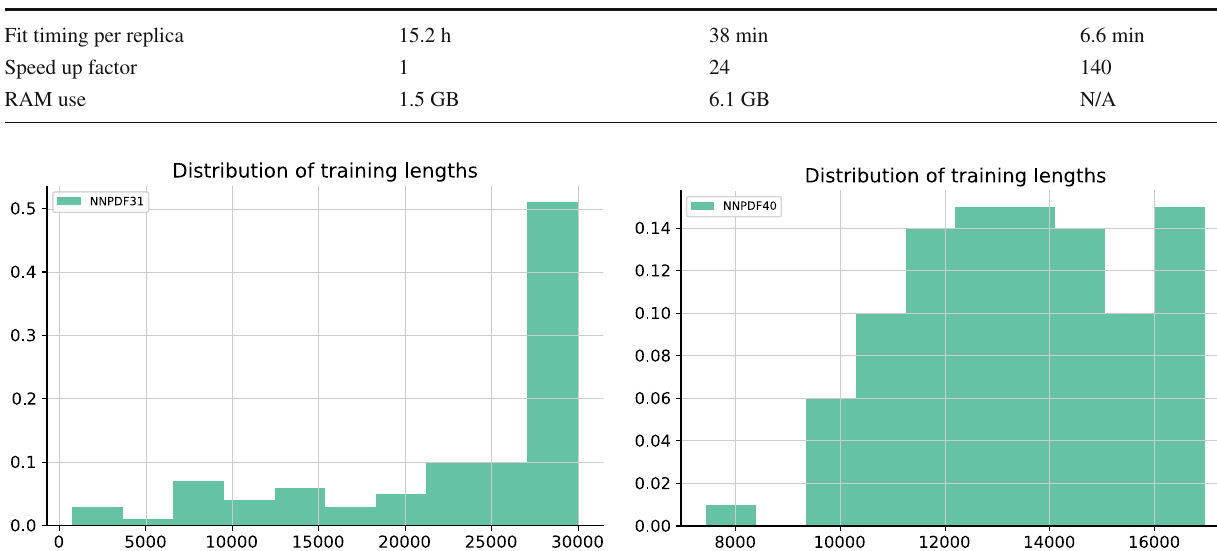
for the same input dataset. In the NNPDF4.0 case, we compare the performance obtained on CPUs with that on GPUs